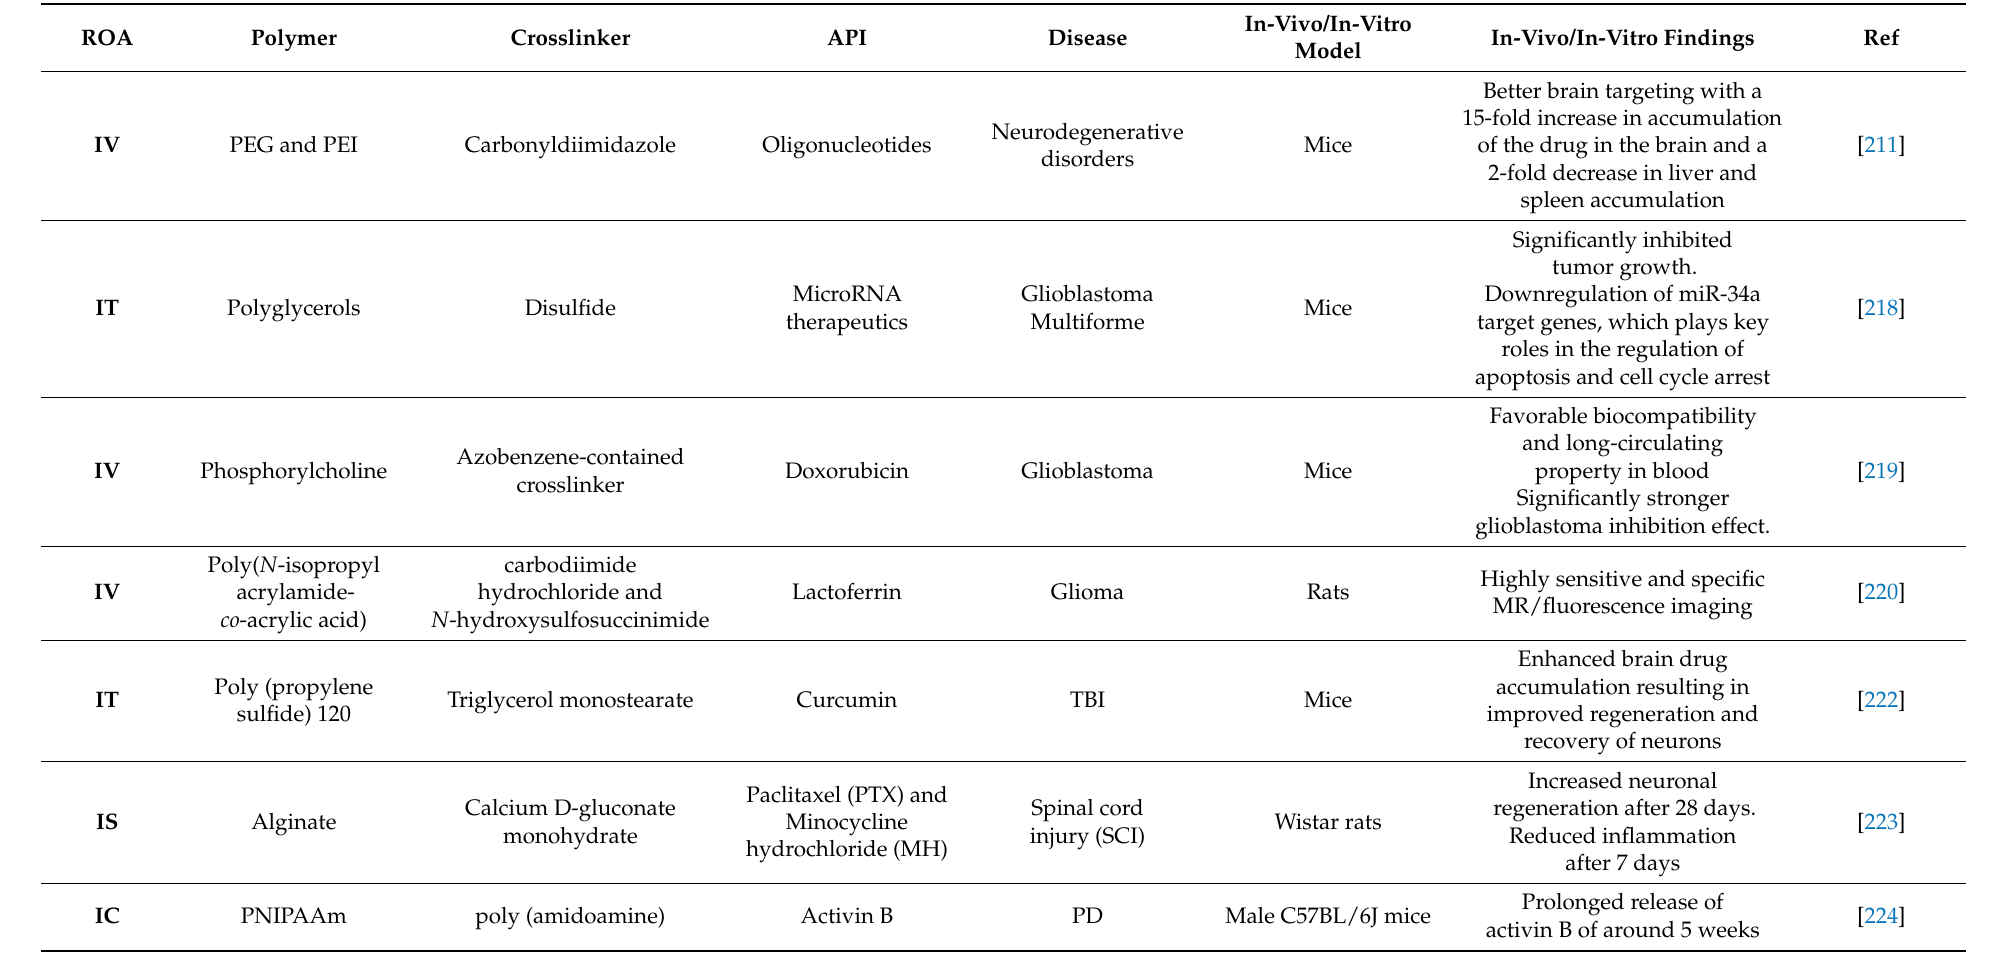
Table 4. Summary of injectable cross-linked gels in CNS